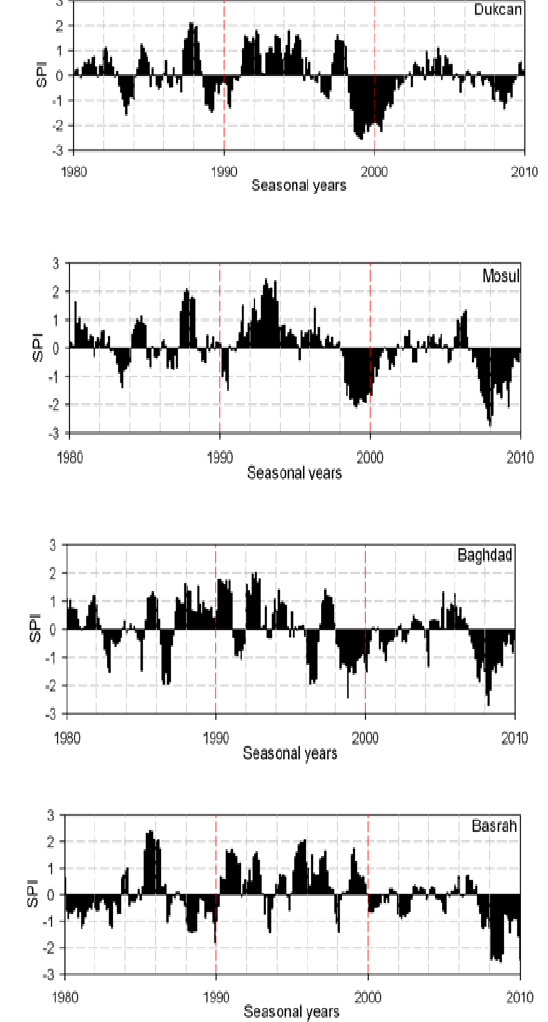
Fig. 2: SPI time series for Dukcan, Mosul, Baghdad and Basrah